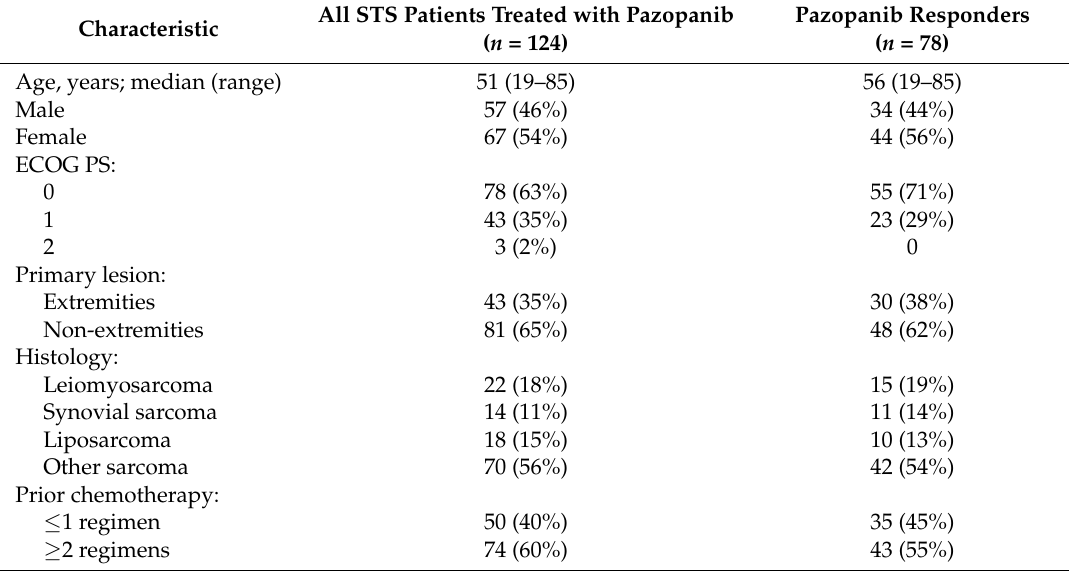
Table 1. Patient characteristics.